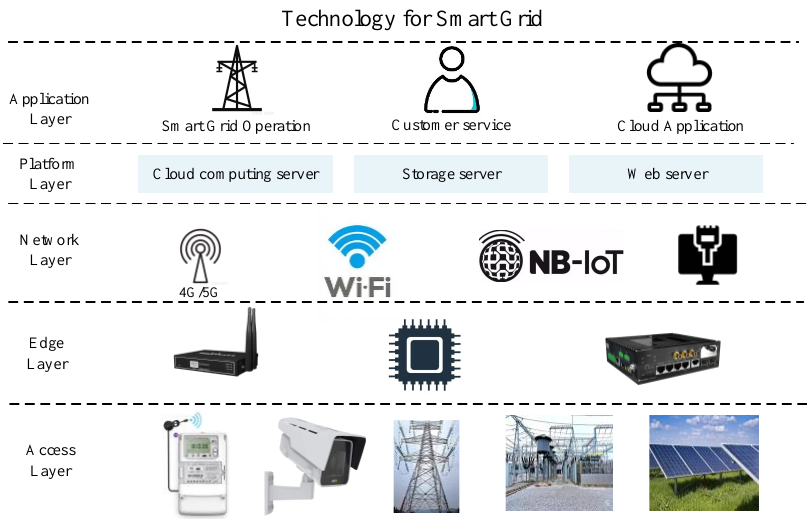
Figure 1. Basic Structure of Edge-enabled Smart Grids.